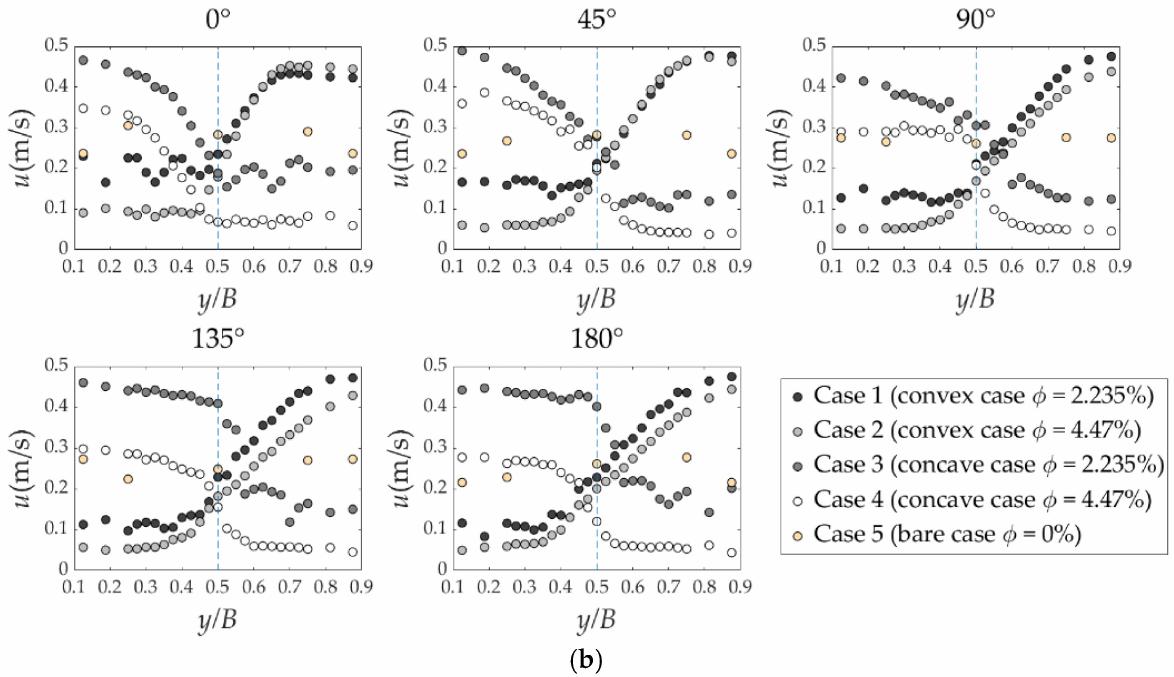
Figure 3. Longitudinal velocity distribution along transverse direction on five cross sections. ( a ) Transverse distribution of longitudinal velocity at different vertical positions in Case 1 ( b ) Trans- verse distribution of longitudinal velocity at z = 12 cm for different